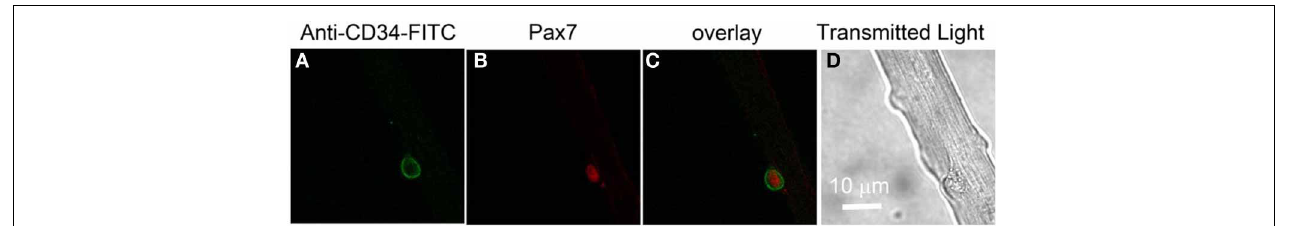
FIGURE 3 | Identification of satellite cells on living FDB fibers. Anti-CD34-FITC antibody was added to the cell culture medium and incubated in the cell culture incubator for 3h. After rinsing with antibody free medium, unbound antibody was washed out and only satellite cells were labeled, with